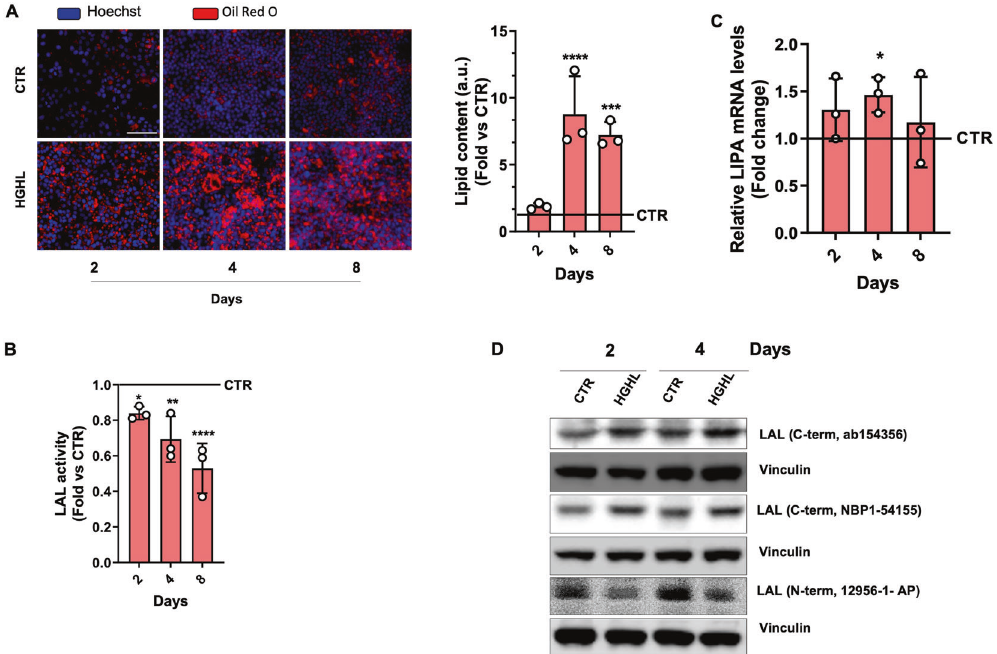
Fig. 1 LAL protein content and activity is affected in an in vitro model of NAFLD. Huh7 cells were cultured in high-glucose/high-lipid (HGHL) medium for 2, 4 and 8 days. A Oil Red O staining to determine intracellular lipids by fl uorescence microscopy (left panel) or by a colorimetric method after Oil Red O elution (right panel). Hoechst 33342 was used to stain nuclei. B LAL activity determined by spectrophotometric enzymatic assay. C Analysis of LIPA mRNA levels by qPCR. D Evaluation of LAL protein content through western blot analysis using different antibodies directed against N-term or C-term epitope. Vinculin was used as loading control. Immunoblots are representative of one experiment out of three giving similar results. Data are expressed as mean ± SD (* p < 0.05, ** p < 0.01, *** p < 0.001, **** p < 0.0001, vs CTR; n =